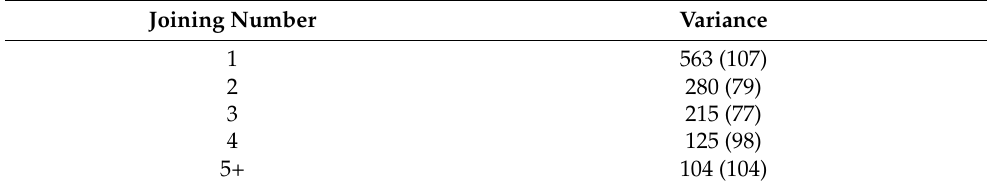
Table 7. Genetic variance component of each joining for Model_1 model with standard error in parenthesis.